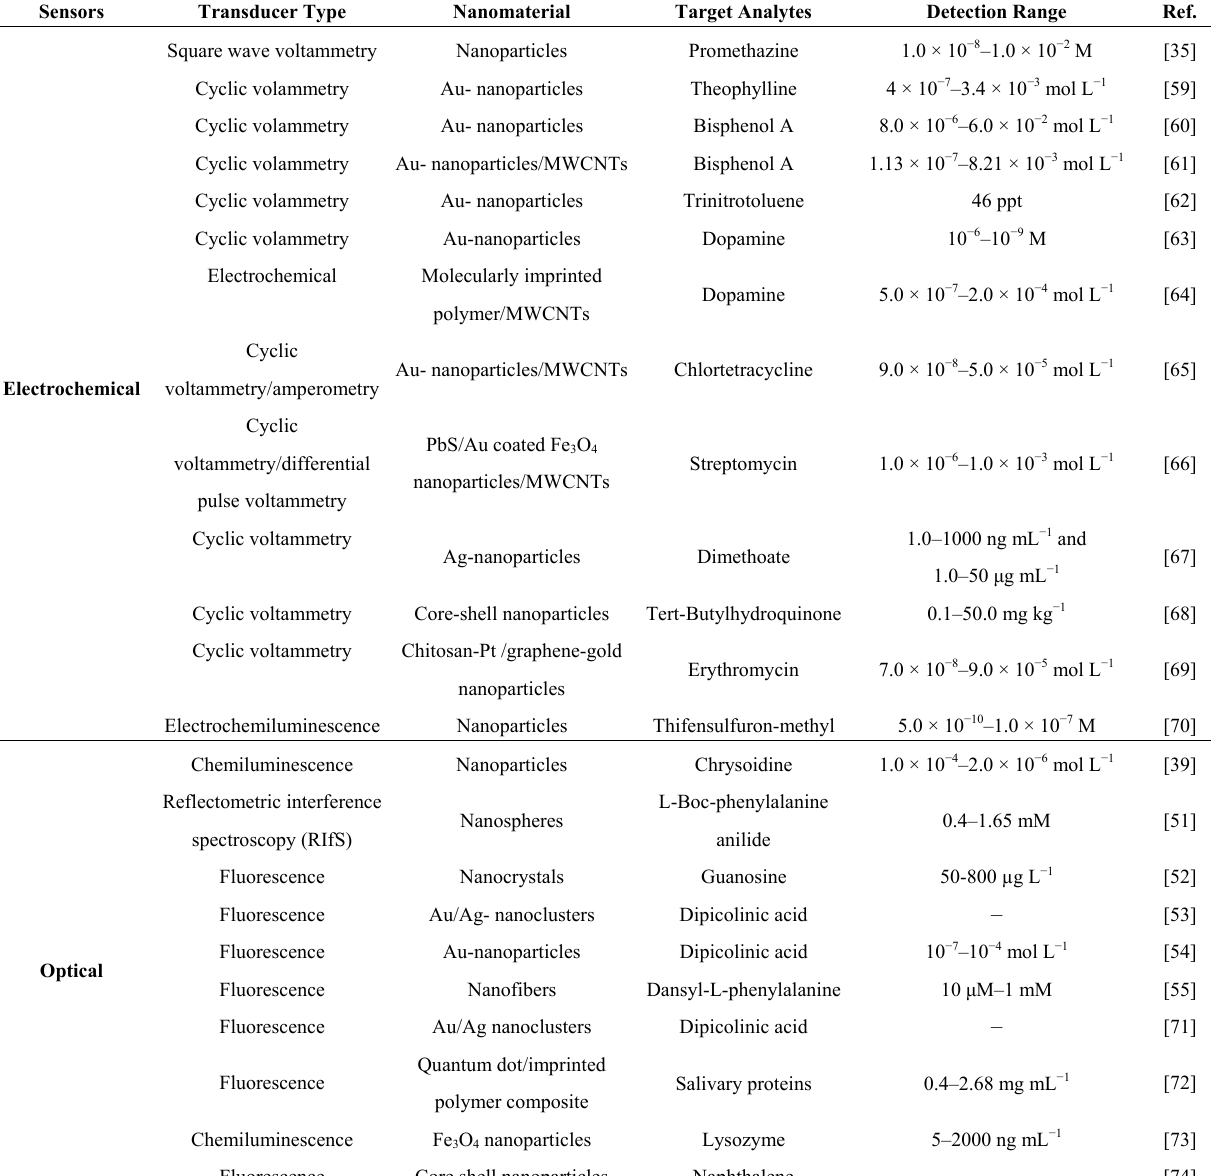
Table 2. Selected examples of various sensors using molecularly imprinted nanomaterials: explaining the underlying principle, the nature of the sensing material, the target analytes and the detection ranges. QCM, quartz crystal microbalance; MWCNT, multi-walled carbon